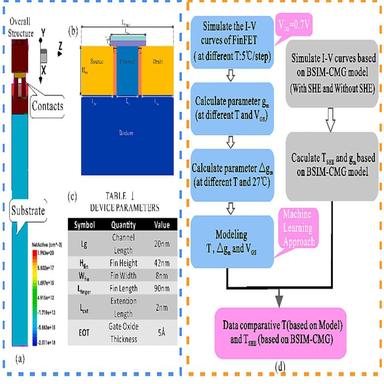
(a) The overall structure of the FinFET devices; (b) The two-dimensional planar structure of the FinFET devices; (c) Device parameters; (d) The overall experimental simulation scheme.